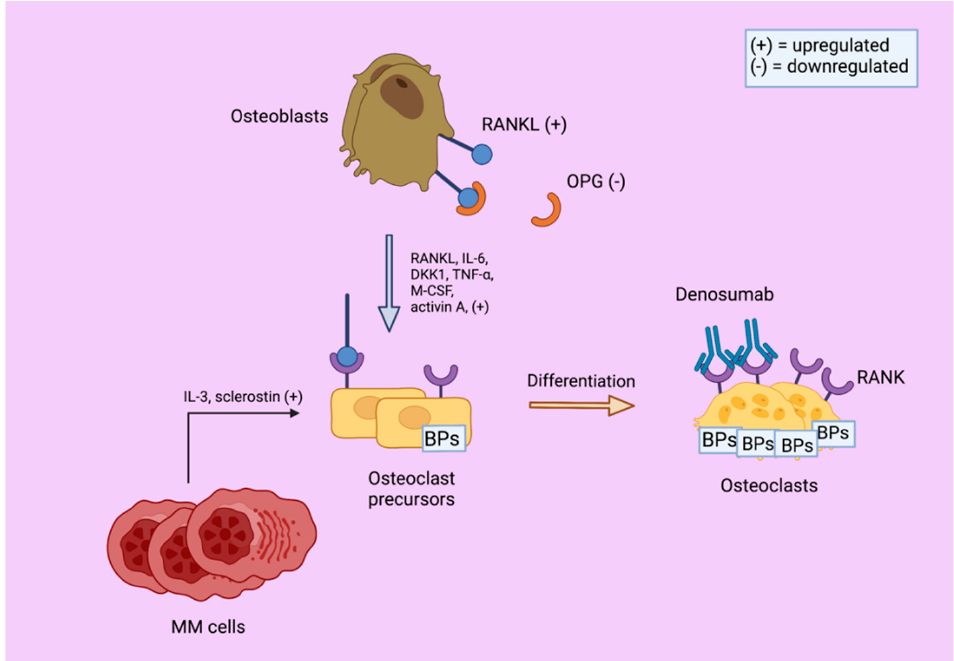
Figure 1. An overview of the interplay between multiple myeloma (MM) cells, osteoclasts, and osteoblasts in multiple myeloma, which favors bone resorption. MM cells induce IL − 6 and DKK1 cytokine upregulation in osteoblasts, which, in effect, upregulates the osteoclast-activating protein, RANKL, while downregulating the anti-resorptive protein, osteoprotegerin (OPG). OPG binds and inhibits RANKL, while MM cells also agonize IL − 3 and sclerostin productions. Denosumab directly inhibits RANKL while bisphosphonates (BPs) (i.e., clodronate, pamidronate, and zoledronic acid) inhibit osteoclasts and osteoclast precursors to prevent osteoclast-induced bone resorption. Created with BioRender.com (accessed on 7 May 2022).